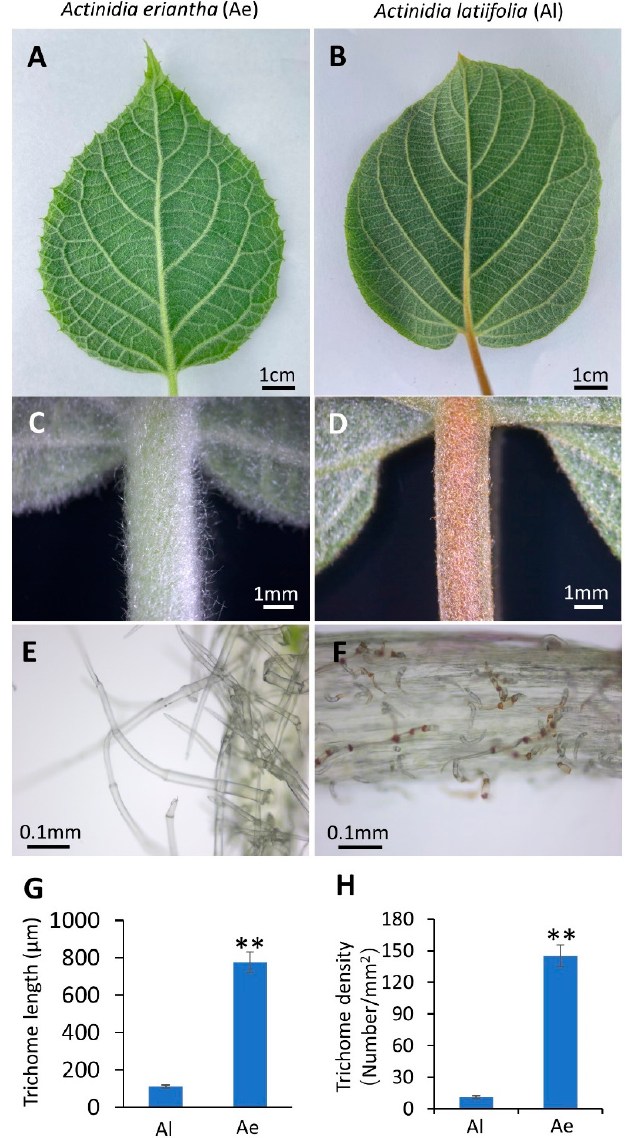
Figure 1. Morphologic observation of trichomes in two kiwifruit species. The mature leaf of A. eriantha , Ae for short ( A ), and A. latifolia , Al for short ( B ). The petioles of mature leaves from Ae ( C ) and Al ( D ). Trichome of petioles of Ae ( E ) and Al ( F ) was observed in microscope. Trichome length ( G ) and density ( H ) are shown in the mean values ± SD from three replicates. Significant differences were determined by Student’s t -test (** indicates p < 0.001).